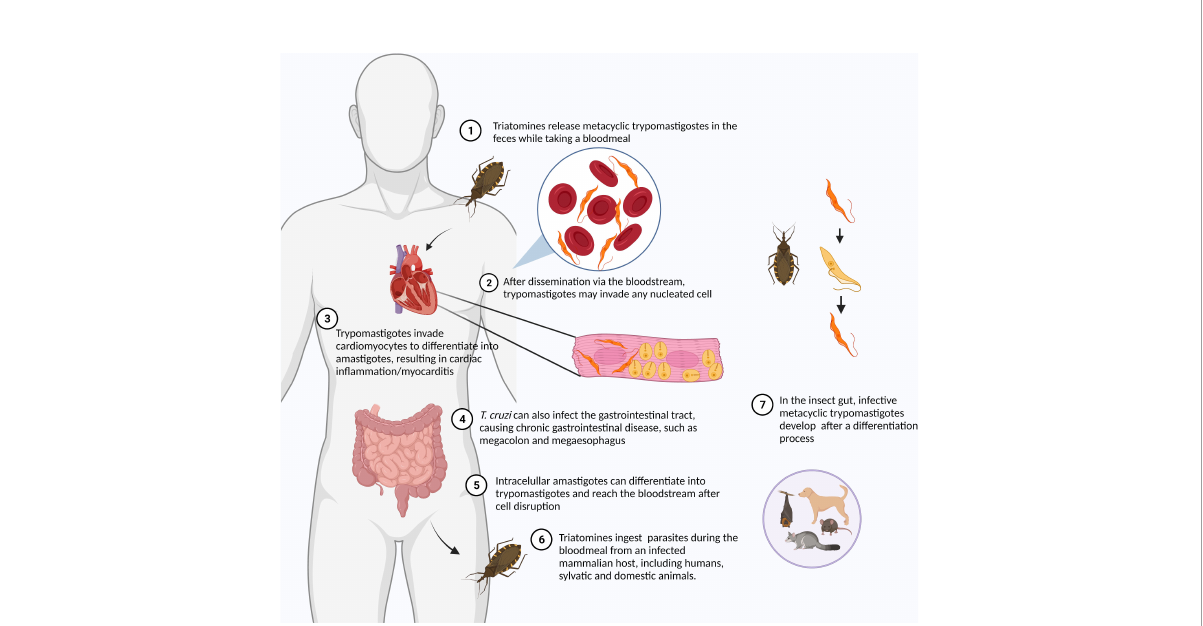
FIGURE 2 Life cycle of Trypanosoma cruzi . The life cycle of T. cruzi alternates between the insect vector – Triatomines or “ kissing bugs ” – and the mammalian host. Metacyclic trypomastigotes are found in insect feces released during the bloodmeal. The parasite reaches the bloodstream through the bite wound or conjunctiva. Once in the bloodstream, T. cruzi can invade any nucleated cells. After invasion, the parasite differentiates into amastigote and multiplies in the host cell cytoplasm. After some cycles of multiplication, intracellular parasites differentiate into trypomastigotes. Trypomastigotes are released in the bloodstream after the host cell disruption being ingested by triatomines while taking a bloodmeal from an infected mammalian host. In the insect gut, different developmental stages of parasites can be found, including epimastigotes and metacyclic trypomastigotes. Created with